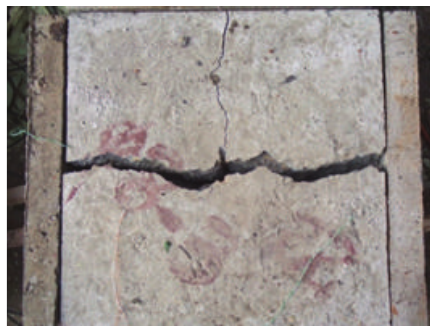
(2) the phase of shock wave unloading: two types of energy, namely, deformation reversion energy 𝐸 𝑟 and wasted energy 𝐸 𝐸 , between which 𝐸 𝑑 is the 𝑑 , are released from sh